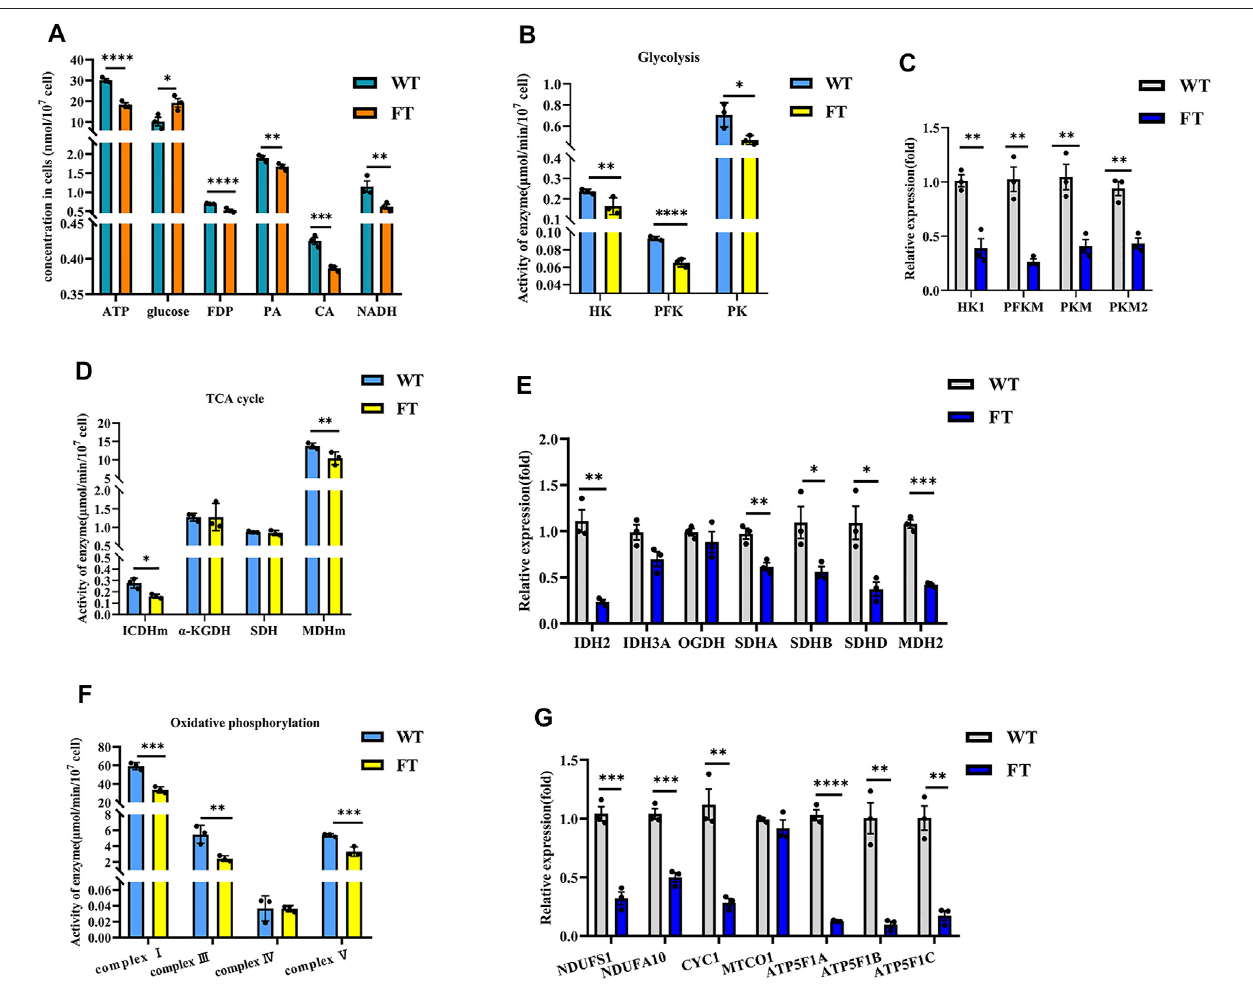
FIGURE 2| Exogenous fat-1 gene is effect on bEFs energy metabolism pathway of cattle. (A) Energy metabolism related product contents ( n = 3). (B,D,F) Activity for key rate-limiting enzymesinvolved in glycolysis (B) and TCA cycle (D) and OXPHOS (F) pathway.( n = 3). (C, (E,G) Expression of mRNA for keyrate-limiting enzymes involved in glycolysis (C) and TCA cycle (E) and OXPHOS (G) pathway by RT-qPCR in FT and WT bEFs. ( n = 3) All assays involving enzyme activity and metabolite concents were statistically calculated by calculating the absorbance in microplate spectrophotometer. Each dot represents an independent experiment. All data are presented as mean ± SEM. Compared with the WT group, * p < 0.05, ** p < 0.01, *** p < 0.001, **** p < 0.0001; t-tests were used to calculate the p